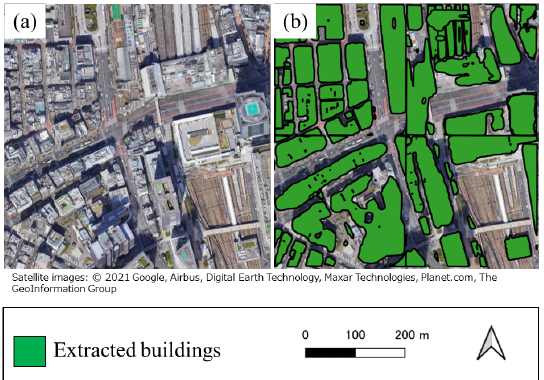
Figure 2. Example of building detection results （ Vicinity of